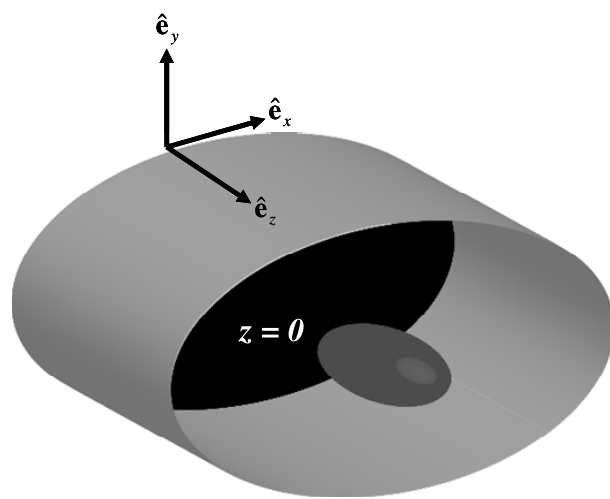
FIG. 1. Schematic of an electron source showing a planar cathode at z (cid:2) 0 , a surrounding pipe which has an arbitrary cross section but is axially uniform for z > 0 , and an accelerating electron